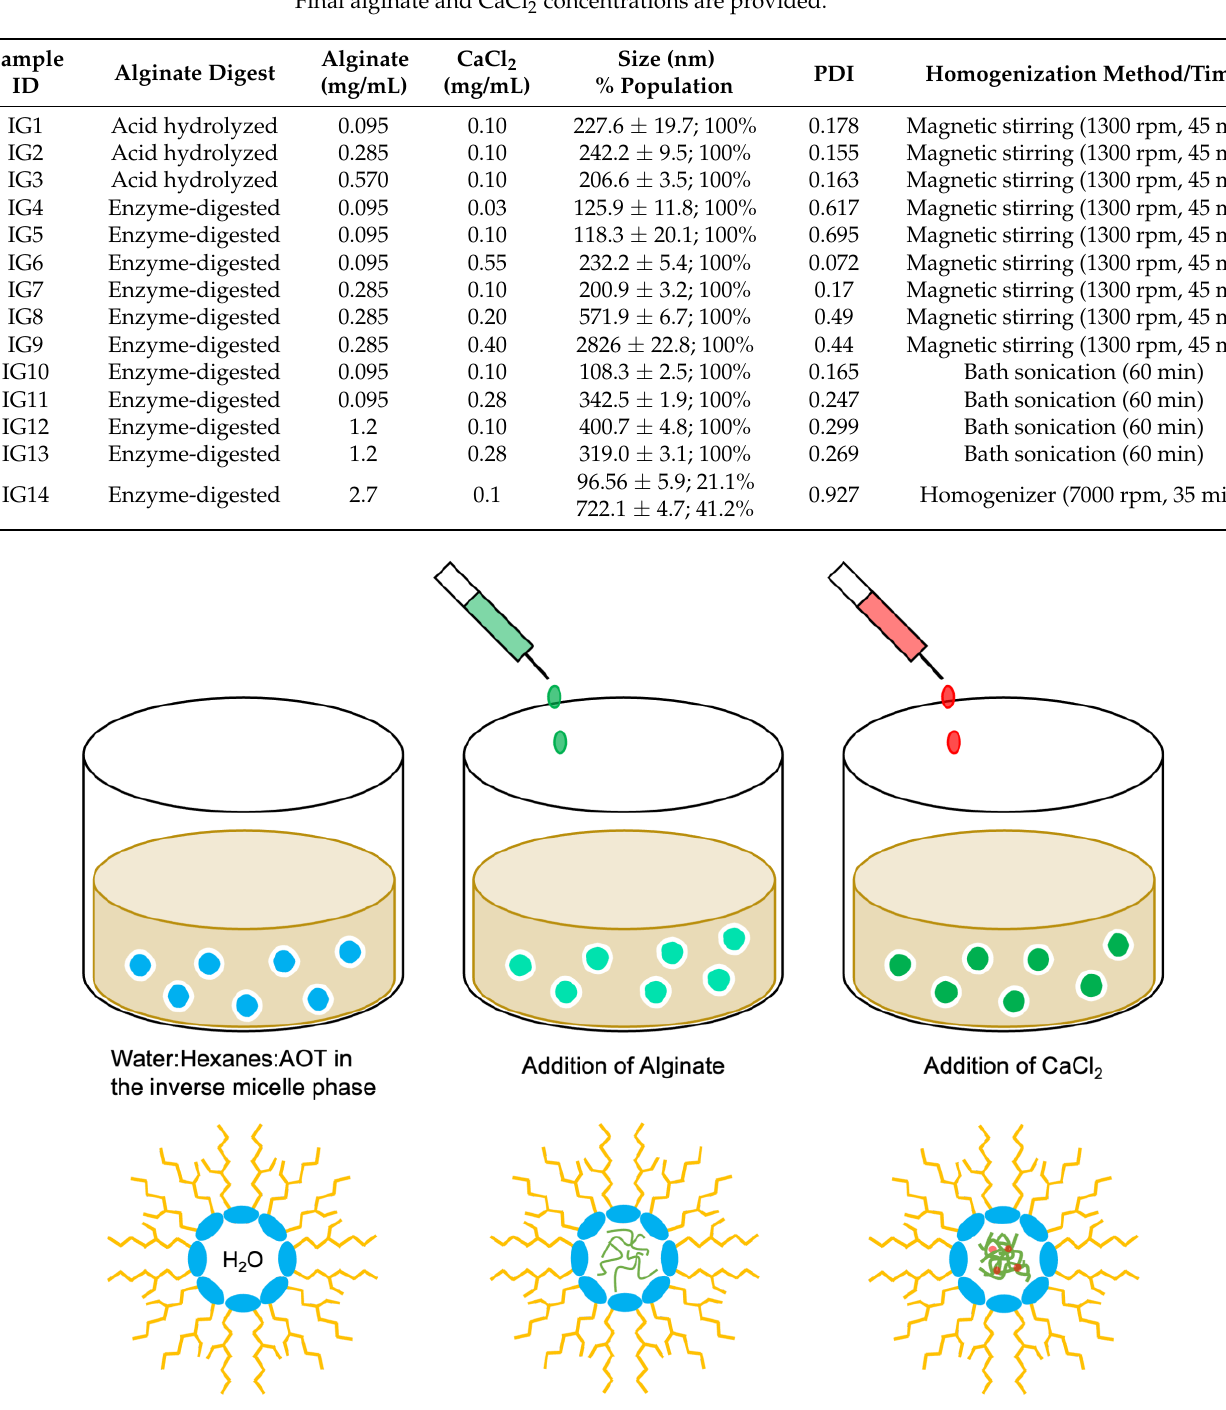
Figure 4. Schematic of AlgNPs synthesis using the water-in-oil emulsification method. The protocol for the water-in-oil emulsification method was adapted from You and Peng (2005) [32]. In order to form the inverted micelle phase, a 20:40:40 water:hex-